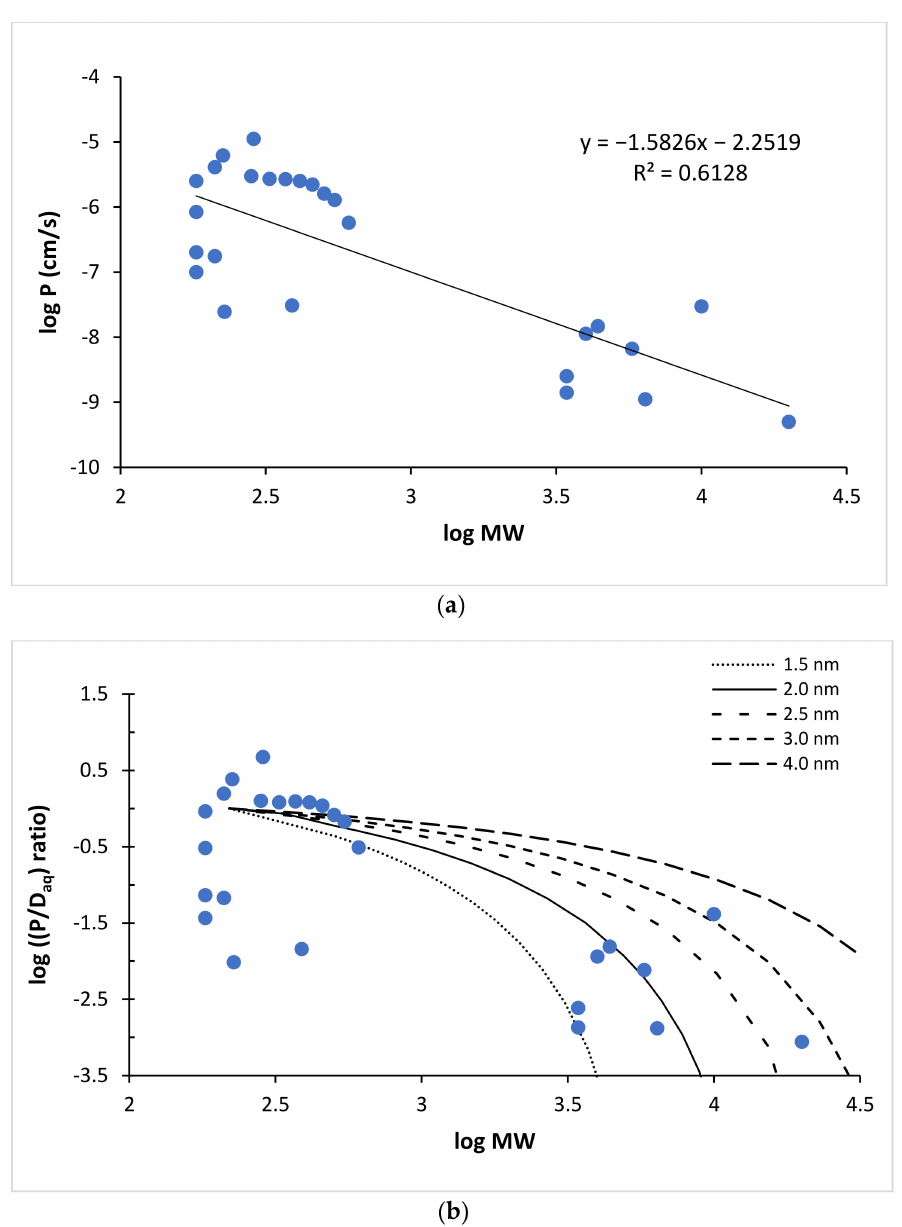
Figure 6. ( a ) Relationship between log P and log MW of polar permeants (pH independent and log K ow < − 1) and macromolecules from Table A1. ( b ) Comparison of the log ( P / D aq ) ratio and log H ratio vs. log MW of the polar permeants and macromolecules. The reference P / D aq and H values in ( b ) are those of a hypothetical small permeant with permeability coefficient and MW equivalent to the average values of the permeants with MW < 300 Dalton in ( a ). Symbols: experimental P / D aq ratio data. Lines: H ratios calculated with pore radius of 1.5 nm (dotted), 2 nm (solid), 2.5 nm (dash-dot), 3 nm (short dashes), and 4 nm (dashes) using Equation